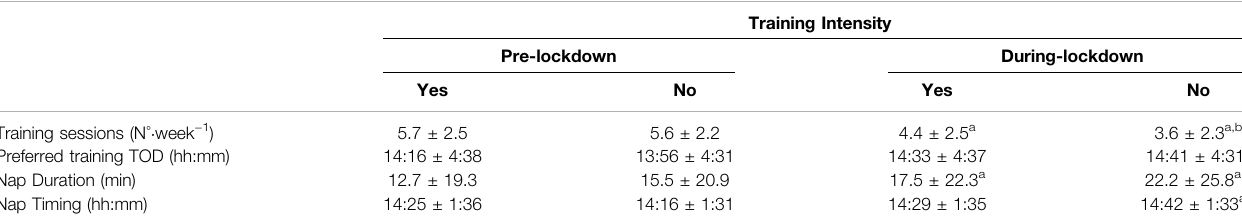
TABLE 2 | Training and napping behavior pre- and during-lockdown according to training intensity.